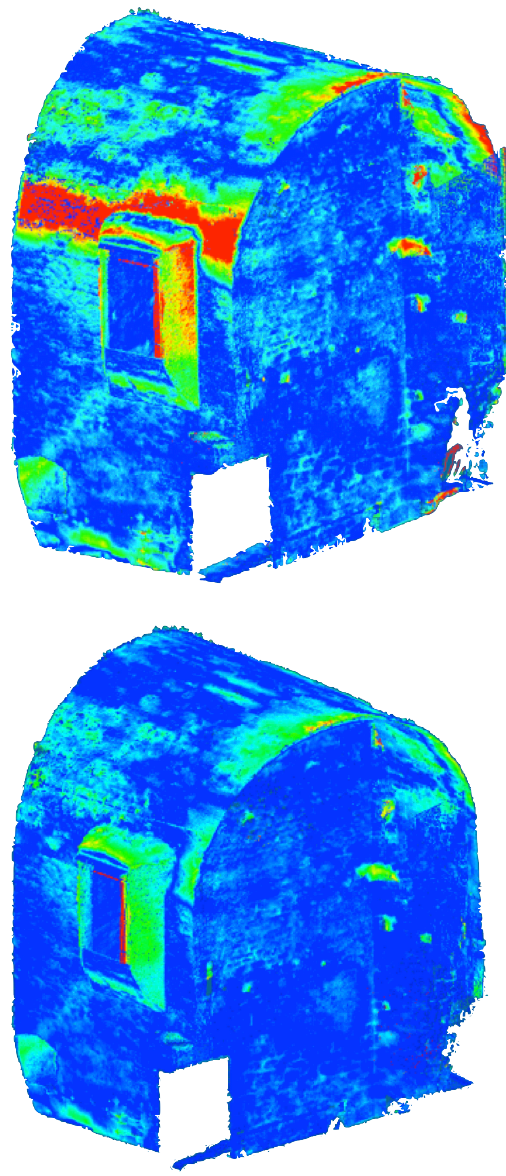
Figure 3. Improving the model by comparing the point cloud; on upper picture, the area in red shows wrong choices corrected on the picture